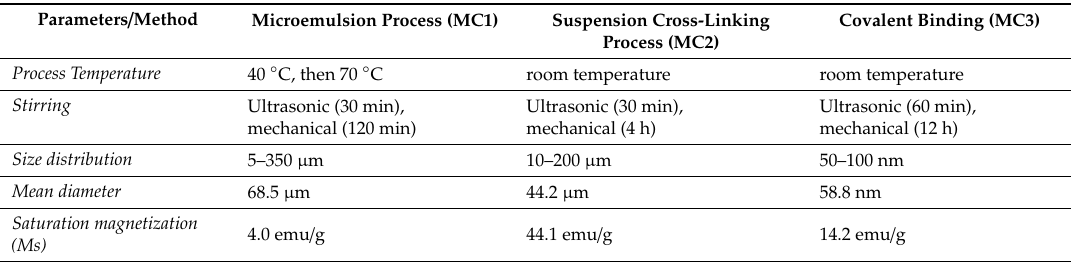
Table1. Comparisonofoperationalconditionsforallthreesynthesisprocessesofchitosanfunctionalized metal oxide micro- and